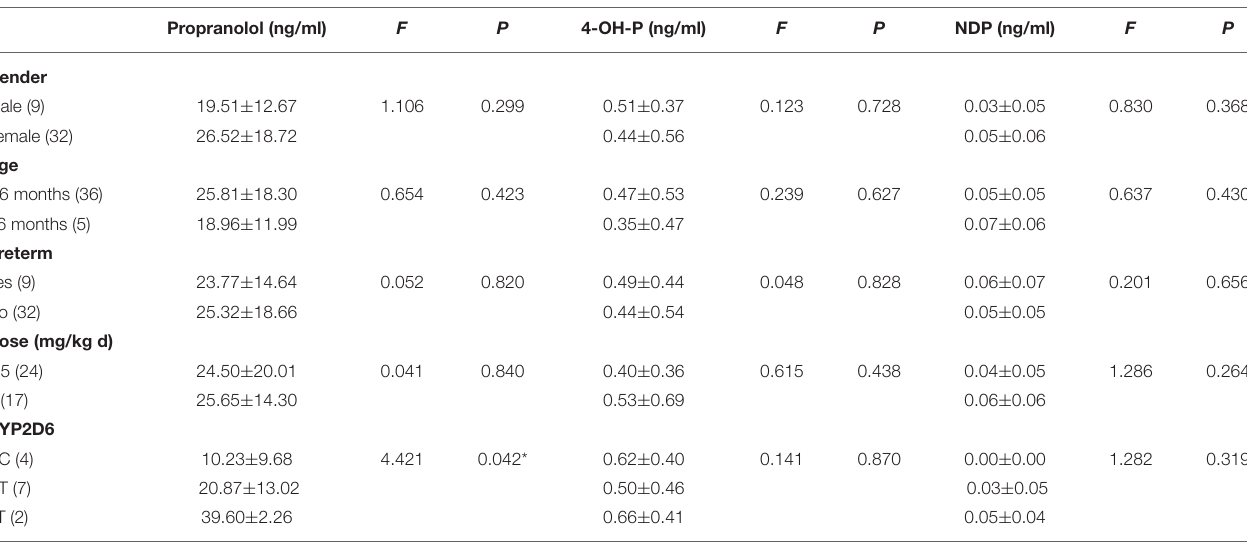
TABLE 2 | The factors affecting the drug blood concentration in the trough concentration group. Propranolol (ng/ml) F P